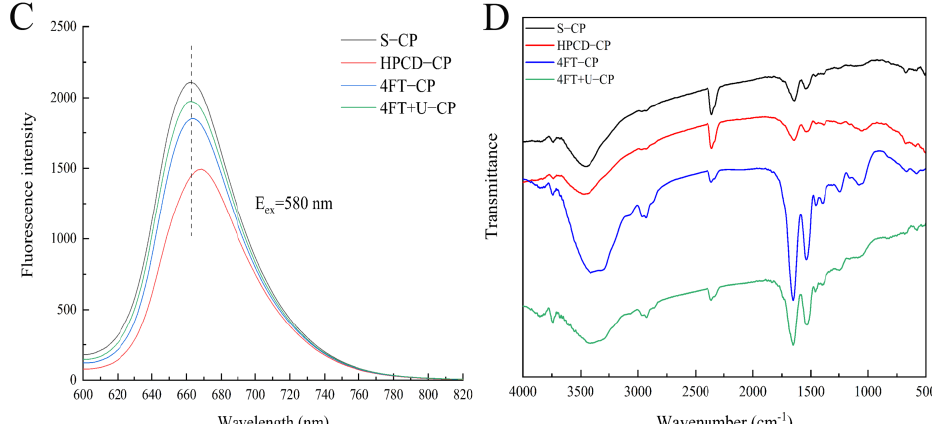
Figure 2. Average particle size ( A ), emission fluorescence spectra (using two different excitation wavelengths: 280 nm ( B ) and 580 nm ( C )), and FTIR spectra ( D ) of CPs obtained using the different methods. Different lowercase letters indicate significant differences ( p <